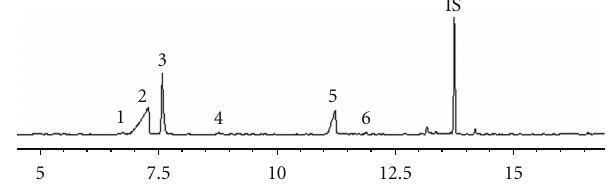
Figure 2: Typical gas chromatogram of a Thaumastocoris peregrinus (Heteroptera: Thaumastocoridae) exuvial extract. Numbers (1–6) correspond, respectively, to benzaldehyde, hexanoic acid, octanal, ( E )-2-octenal, octanoic acid, and decanal. Extracts were analyzed on a Shimadzu GC MS-QP 2010; the internal standard (IS) was